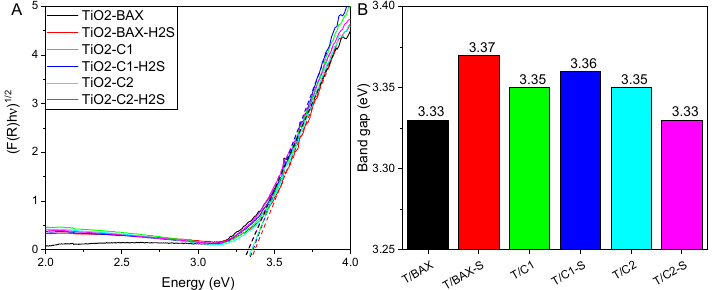
Figure 9. ( A ) Tauc plots for indirect allowed transitions. ( B ) Indirect optical band gaps of the different materials.